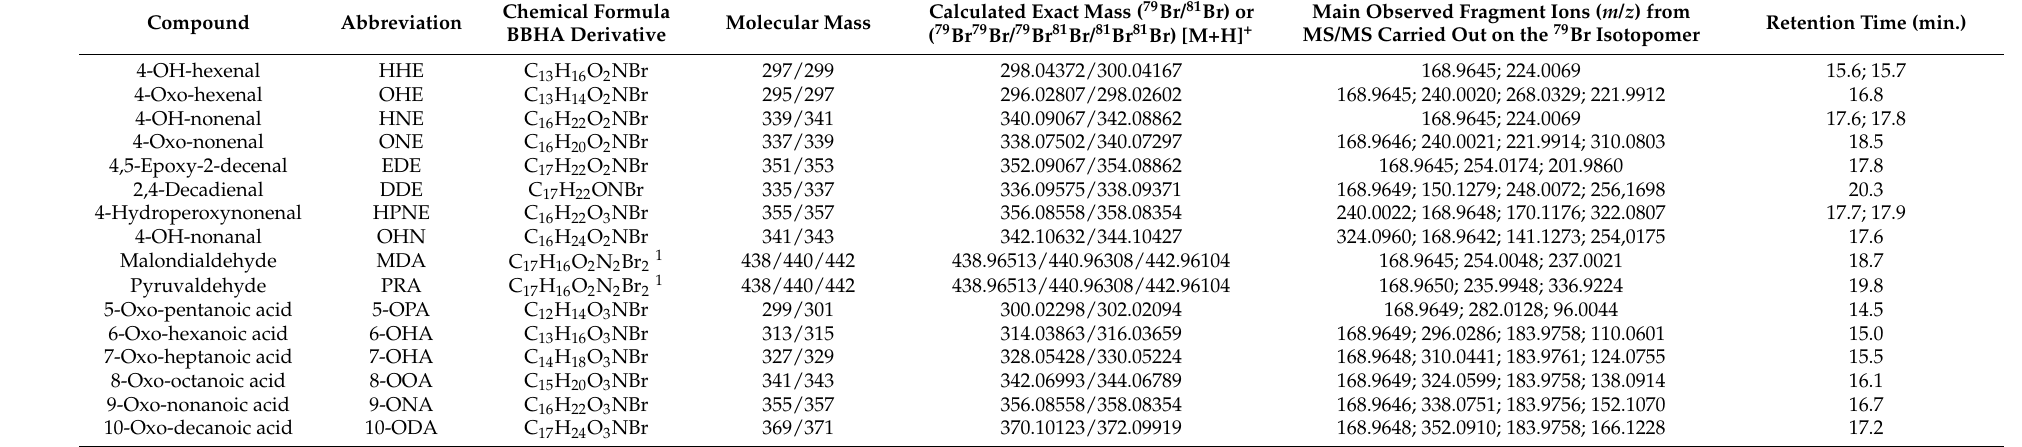
Table 1. List of prepared standard BBHA derivatives and their respective molecular mass, exact mass of the [M+H] + ion, main MS/MS fragment ions, and chromatographic retention times.